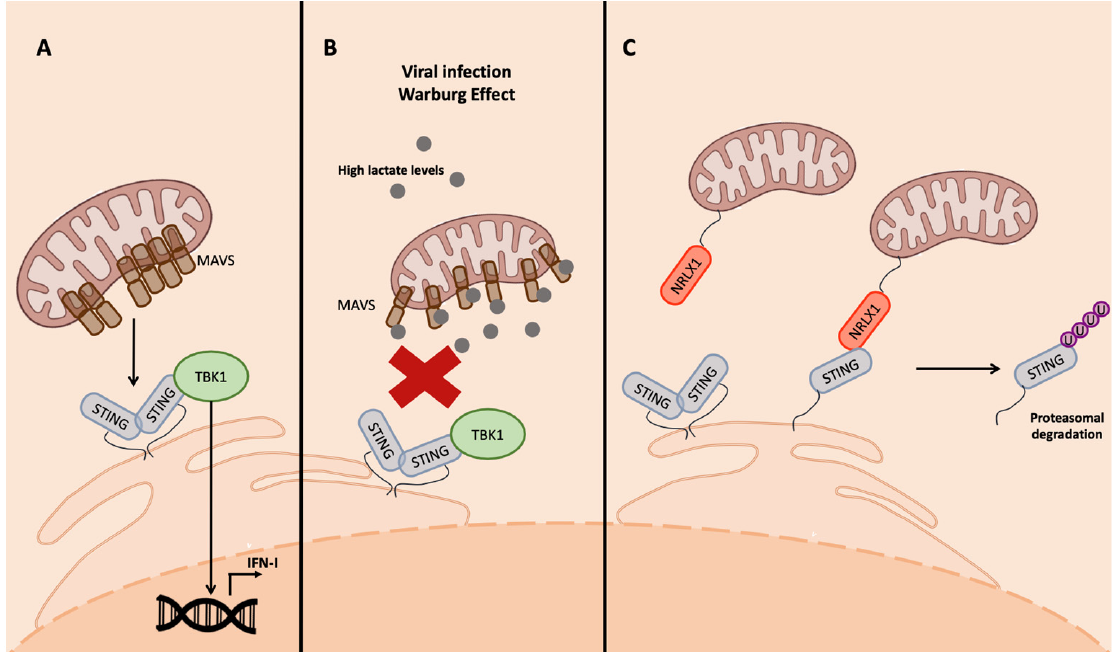
Figure 4. Inhibition of STING interaction with MAVS. ( A ) MAVS interaction with STING is required for the activation of RIG-I-mediated IFN-I transcription. In physiologic conditions, MAVS aggregate in the mitochondrial surface and bind STING, leading to its aggregation and activation of IFN-I transcription. ( B ) Viral infection, as well as tumorigenesis, can lead to the production of lactate as a bioproduct of aerobic glycolysis; lactate binds MAVS that cannot aggregate and, as a consequence, the MAVS–STING interaction is impeded. ( C ) NLRX1 in viral-infected cells inhibits the MAVS– STING interaction through direct binding with SITNG, leading to its proteasomal degradation.